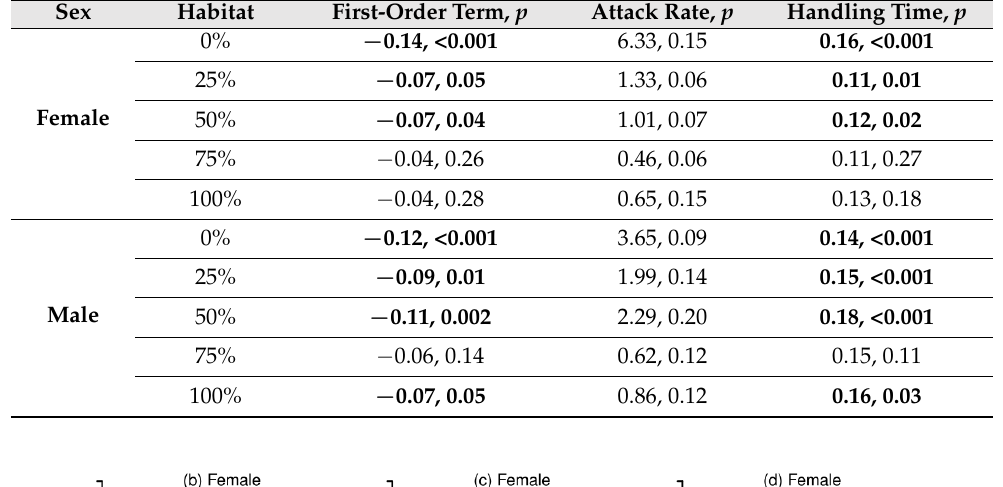
Table 1. Mesopodopsis wooldridgei functional response first-order terms, attack rates, and handling times across predator sex and habitat complexity treatments, along with associated p -values. Signifi- cant p -values are emboldened.